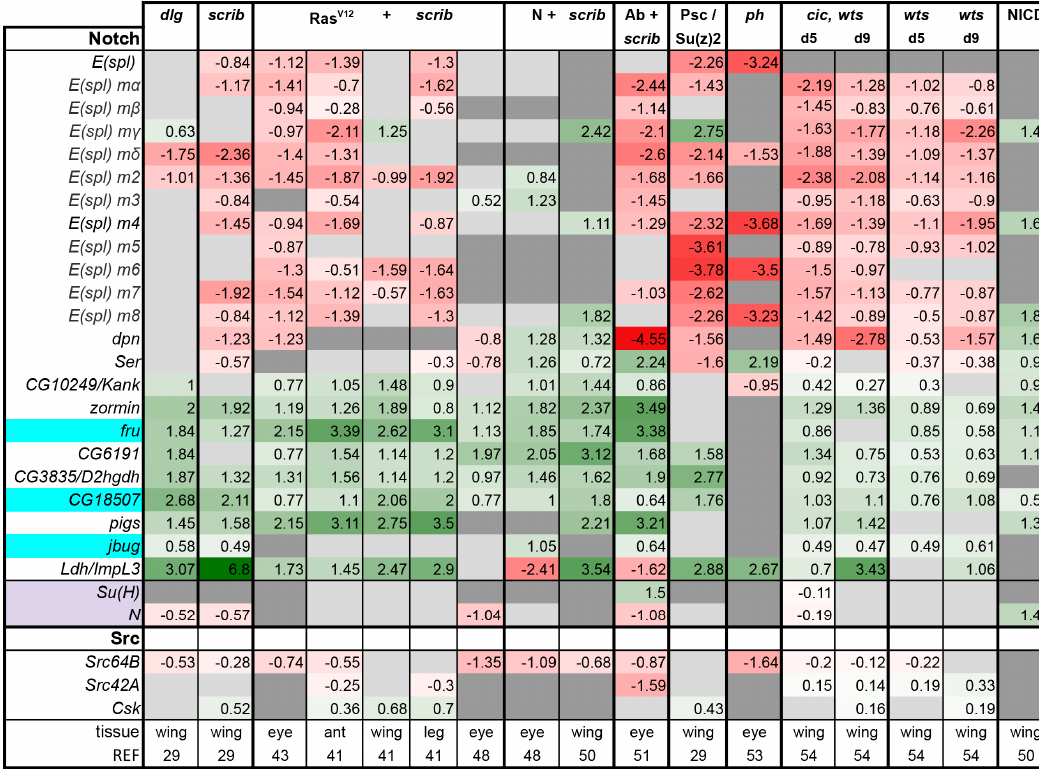
Figure 7 . E (spl) genes are downregulated, whereas the other N target genes are induced in tumors. Light purple highlights the nuclear factors the pathway. Genes highlighted in cyan are predicted Yki/Sd targets [41]. Gene expression is displayed in log2FC. Color coding corresponds to a heatmap with a scale from -5 (dark red) to 5 (dark green). Light grey cells represent non-significant changes with p > 0.05. Dark grey: the gene was not found in the datasets. Abbreviations: Enhancer of split, E(spl); deadpan, dpn; Serrate, Ser; fruitless, fru;